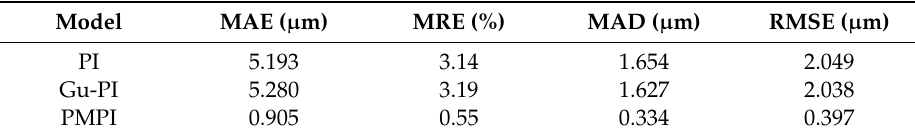
Table 3. Comparison of three model errors in Case